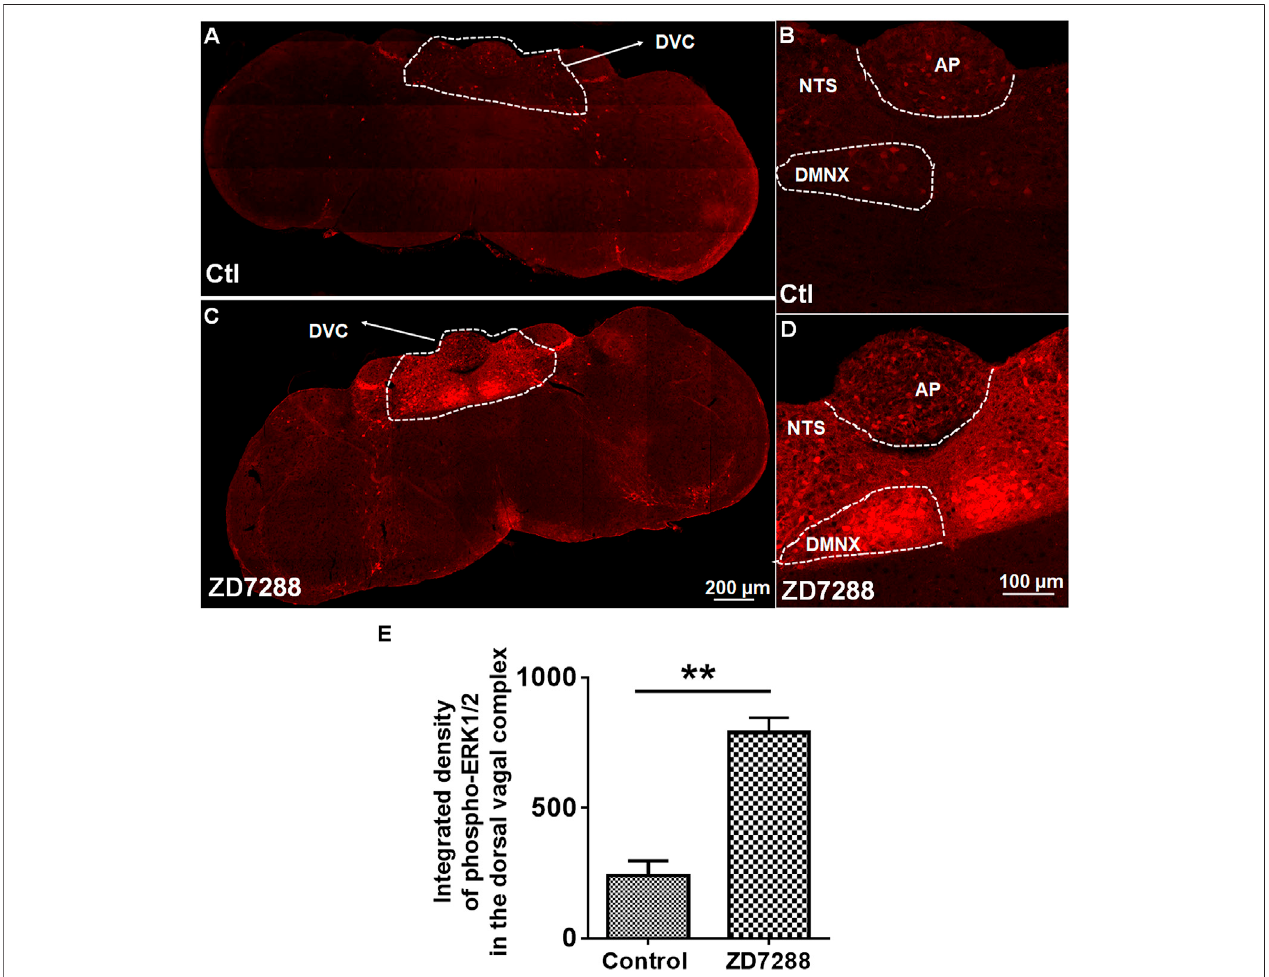
FIGURE8 | Immunohistochemical analysisofERK1/2phosphorylation following the HCN channel blockerZD7288-induced emesis. Least shrews were sacri fi ced 15 min after vehicle or ZD7288 injection (1 mg/kg, i. p.) ( n (cid:2) 3 shrews per group). Brainstem sections (20 μ m) and intestinal jejunum sections (25 μ m) were stained with rabbitanti-phospho-ERK1/2antibodyandAlexaFluor594donkey anti-rabbitsecondary antibody.NucleiwerestainedwithDAPIinblue. (A,C) Representativetilescan images show a strong upregulation of ERK1/2 phosphorylation (pERK) in the brainstem dorsal vagal complex (DVC) in response to ZD7288. Scale bar, 200 μ m. (B , D) Representative images show ERK1/2 phosphorylation evoked by ZD7288 seen in the DVC throughout three emetic nuclei, the area postrema (AP), the nucleus tractus solitarius (NTS) and the dorsal motor nucleus of the vagus (DMNX). Scale bar, 100 μ m. (E) Statistical analysis of integrated density of ERK1/2 phosphorylation evoked by ZD7288 (1 mg/kg, i. p.) in the brainstem dorsal vagal complex. ** p < 0.01 vs. Control, Unpaired t